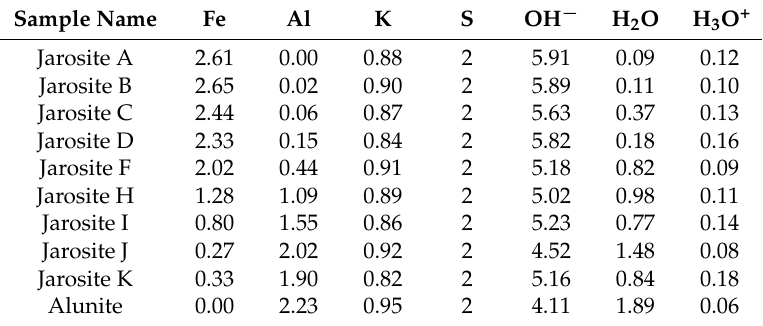
Table 2. Moles and elemental composition of solids formed.